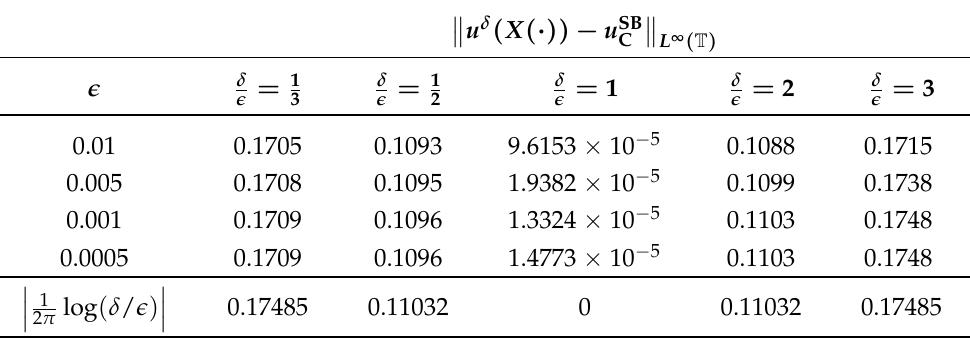
Table 1. L ∞ norm of the difference between fiber velocity expressions u δ ( X ( s )) (22) and u SB (11) for different ratios of δ / (cid:101) . Note that δ much larger than the fiber radius. Here we have prescribed the constant force f = e x and use 2 discretization points to fully resolve the behavior of the nearly singular integrals.